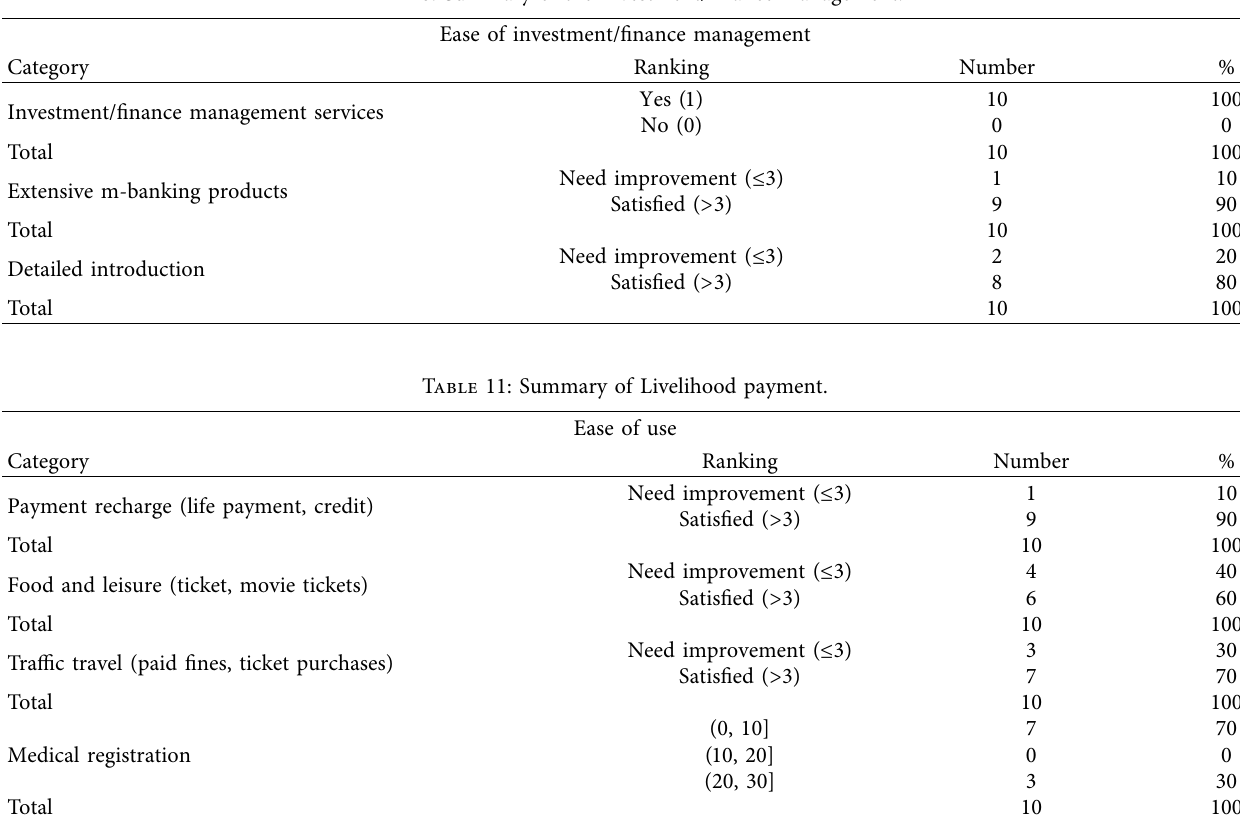
Table 10: Summary of the investment/finance management.